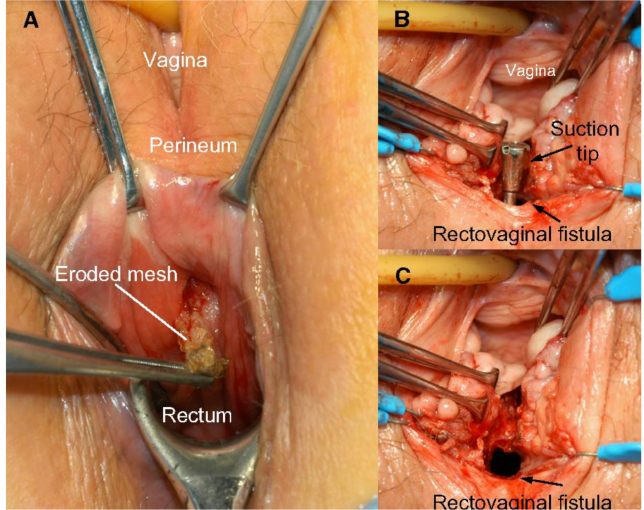
Figure 3. ( A ) Rectovaginal fistula formation secondary to mesh erosion through posterior vaginal wall; ( B ) rectal side of rectovaginal fistula after mesh removal; and ( C ) vaginal side of rectovaginal fistula after mesh removal. Reprinted with permission from Margulies et al. (2012) [34]. Copyright Elsevier, 2008.